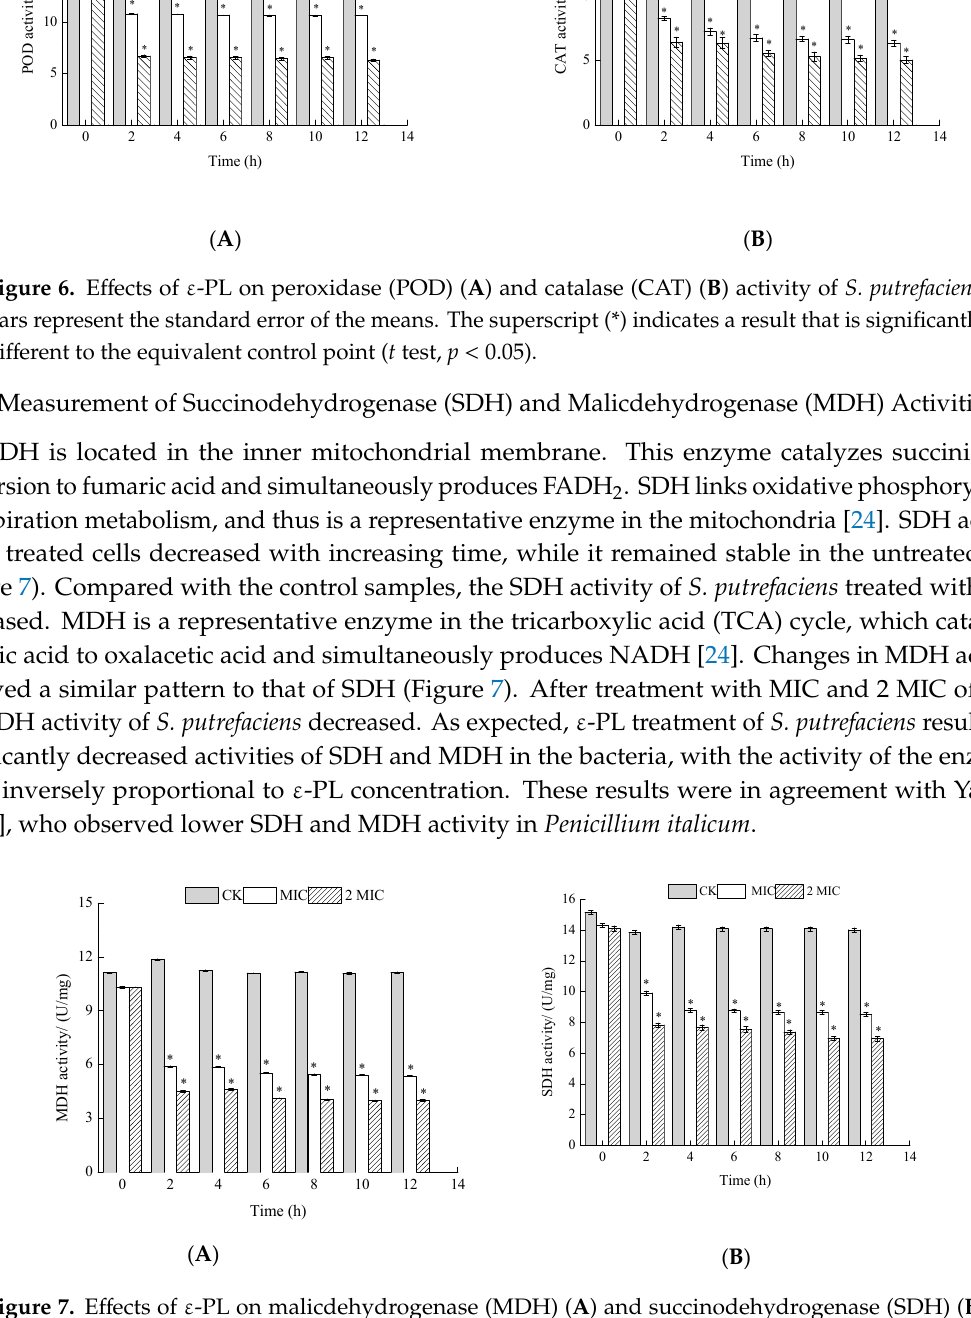
Figure 7. Effects of ε -PL on malicdehydrogenase (MDH) ( A ) and succinodehydrogenase (SDH) ( B ) activity of S. putrefaciens. Bars represent the standard error of the means. The superscript (*) indicates a result that is significantly different to the equivalent control point (t test, p < 0.05 ).